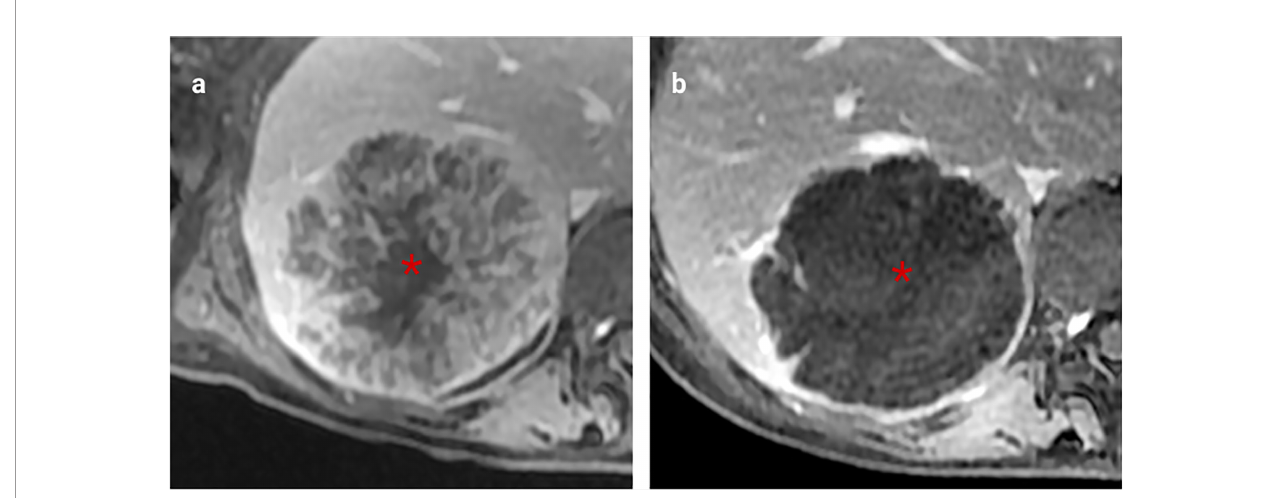
FIGURE 6 | Excellent morphological response to chemotherapy. (A) . Heterogenously enhancing CRLM on portal venous phase T1-weighted MRI (asterisk). (B) , Post-chemotherapy MRI shows the lesion has become homogenous without a reduction in size, indicating a signi fi cant decrease in viable tumour